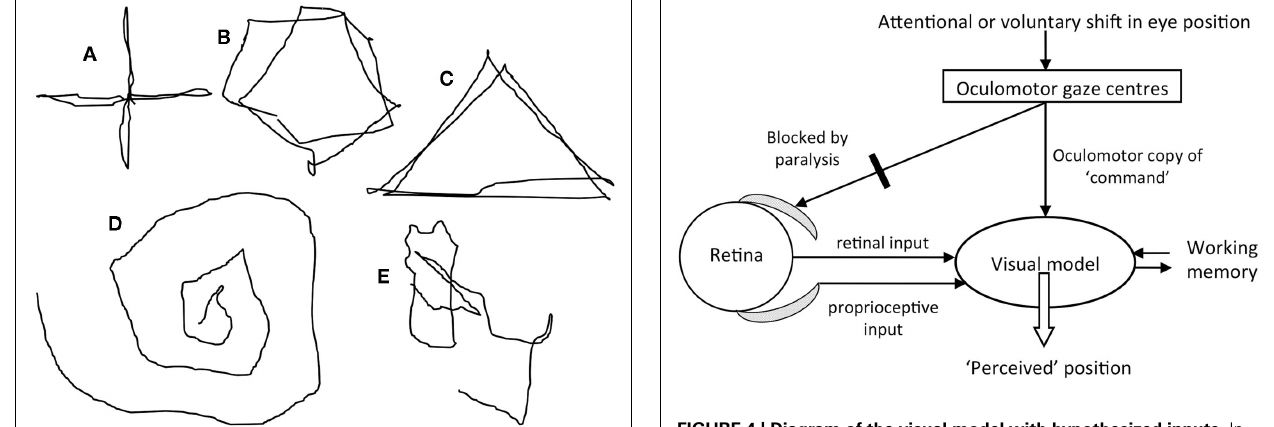
FIGURE 4 | Diagram of the visual model with hypothesized inputs. In this study, blockade by cisatracurium of ocular muscles left proprioception unchanged and visual input stationary.We varied the strength of visual input by using illumination and darkness, and varied oculomotor center activity by requesting attentional or voluntary eye-movements.The reported experiences indicated that the “oculomotor copy” was able to bias the construction of the visual model, especially when illumination was